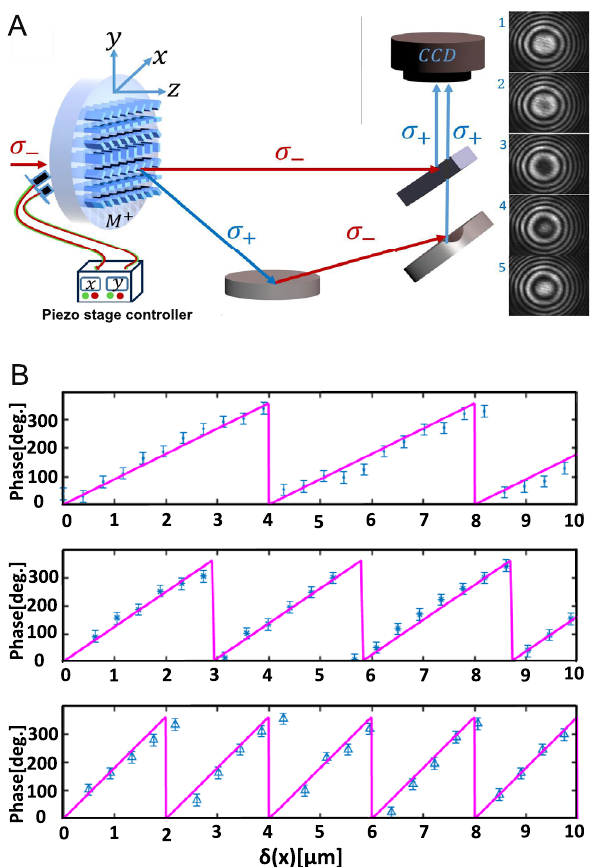
Figure 3: (A) (Left) Schematic of the interferometric measurement for the characterization of the topological phase shift introduced by Pancharatnam – Berry (PB) metasurface as a 50/50 CP beam splitter. (Right)Theinterferencefringesdisplacementaccordingtothephase gradient direction δ x , resulting from the topological phase delay shift introduced on the anomalous beam. (B) The measured phase delays as a function of the displacements are reported for three different gratings, with periods Γ = 4, 2.9 and 2 μ m from top to bottom,